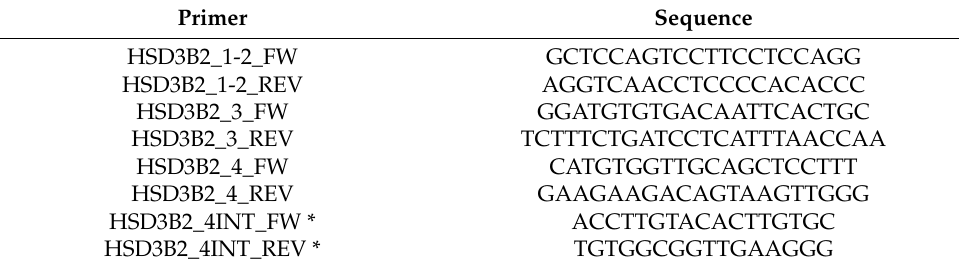
* Internal primers for sequencing. FW = forward. REV =